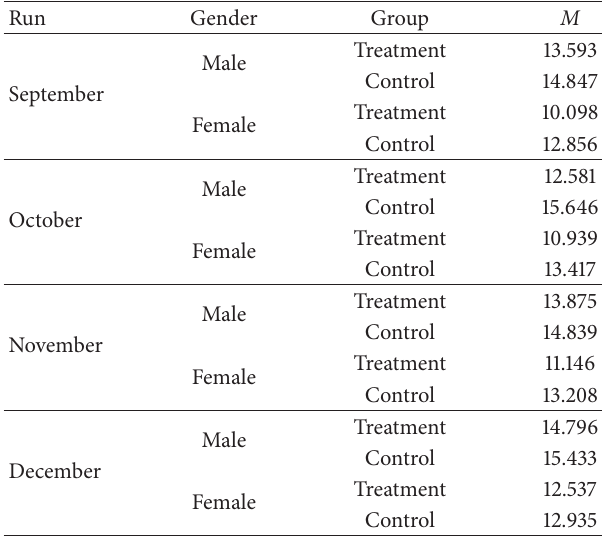
Table 2: Monthly lap run